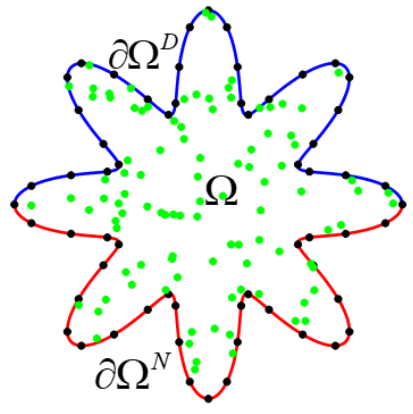
Figure 1. The node distribution of the traditional RBFCM (boundary nodes “ • ”, interior nodes “ • ” ).